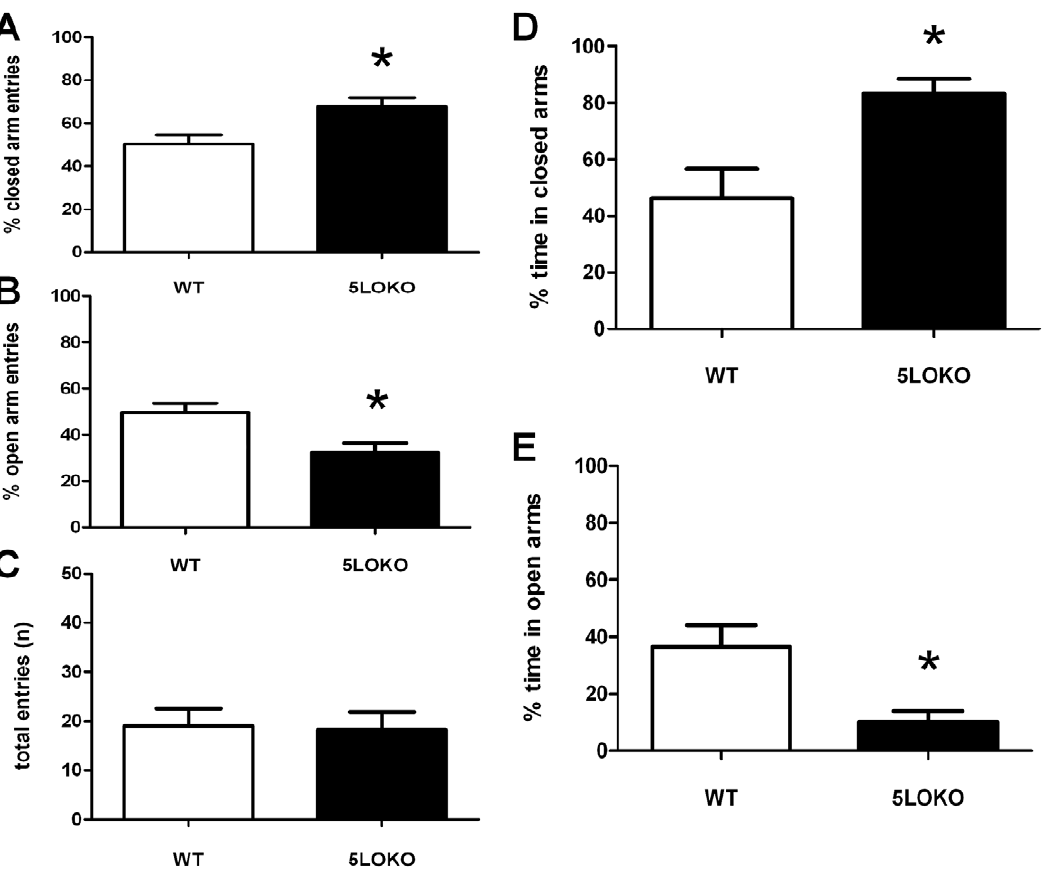
Figure 3. Elevated plus maze behavior in 12 mo old mice. Percentage of total entries into the closed arm (A), open arm (B), total arm entries (C) and percentage of total time spent in closed (D) and open arm (E). 5LO-KO mice (closed arms) entered the closed arms more and entered open arms less than wild type (WT) animals (open arms). 5LO-KO animals also spent more time in the closed arm and less time in the open arm than WT mice. No differences in total arm entries were noted. (WT, n=4, 5LO-KO, n=6).